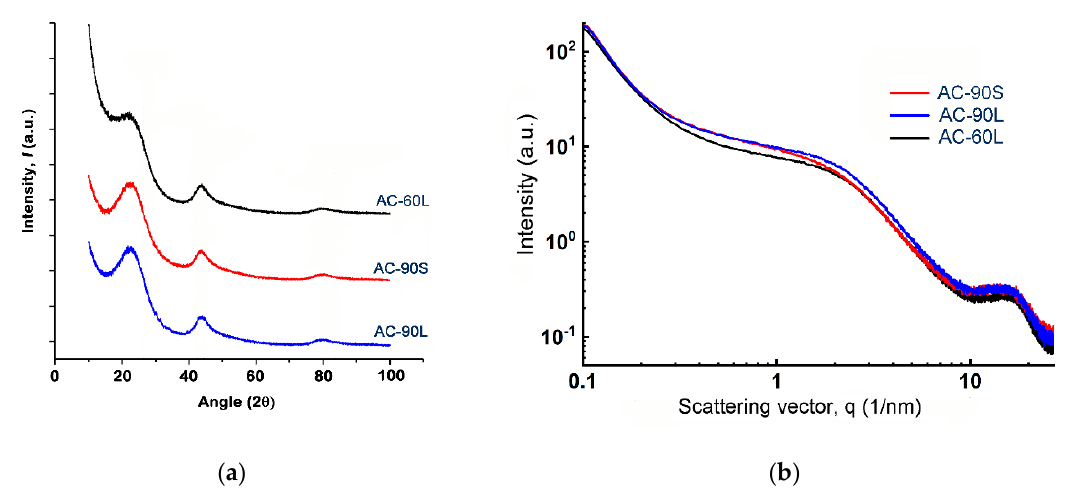
Figure 6. X-ray diffraction (XRD) ( a ) and small-angle X-ray scattering (SAXS) ( b ) patterns for the CNS-derived activated carbons.